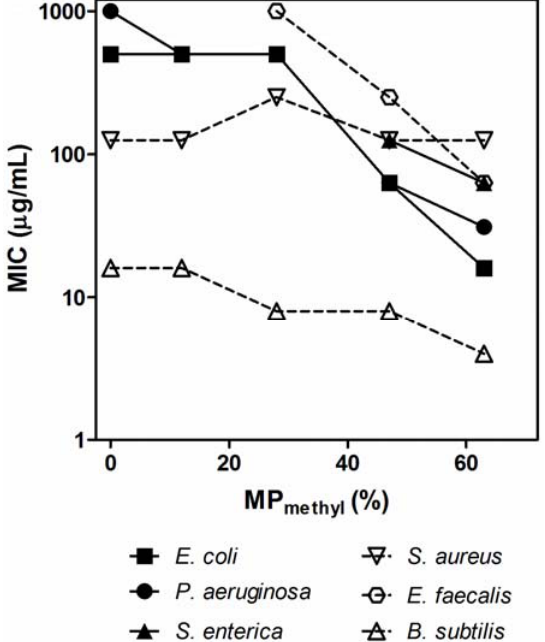
Figure 2. Activity spectrum of PM polymer series against G-negative ( open markers and dashed lines ) and G-positive ( closed markers and solid lines ) bacteria. The minimum inhibitory concentration (MIC) values > 1,000 µg/mL are not plotted.